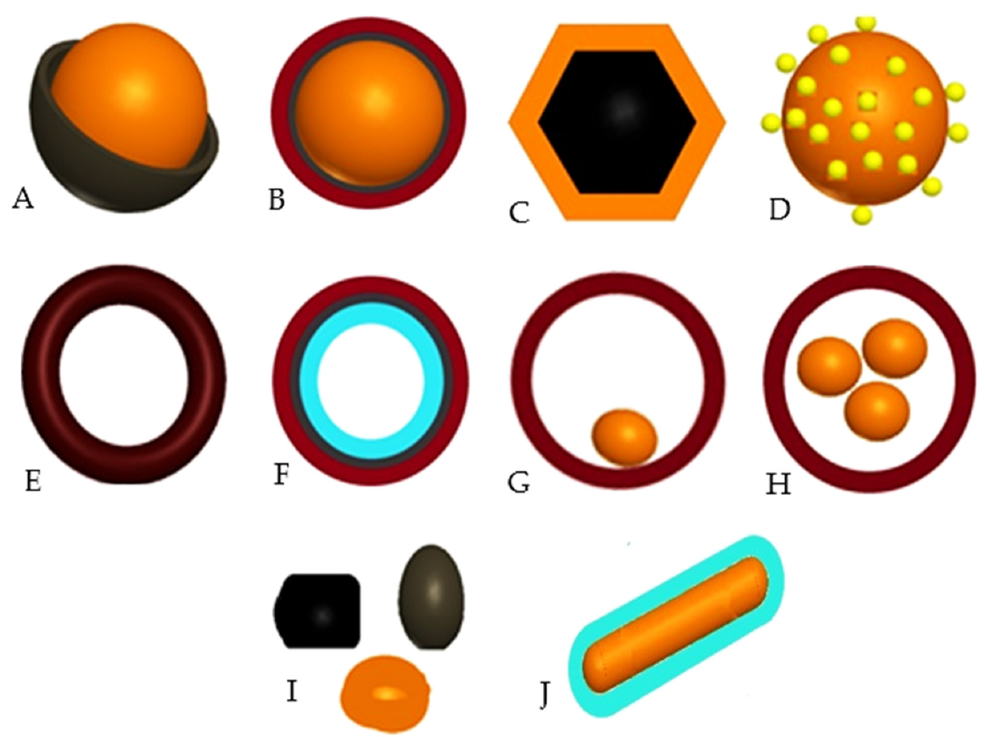
Figure 3. Schematic ( A – J ) pictures of different structure of core shell nanoparticles: ( A ) Core shell nanoparticles; ( B ) Core double-shell particles or core multi-shell nanoparticle; ( C ) Polyhedral core/shell nanoparticles; ( D ) Core porous-shell nanoparticles; ( E ) Hollow-core shell nanoparticles or single-shell core/shell nanoparticles; ( F ) Hollow-core double-shell nanoparticles; ( G ) Moveable-core shell nanoparticles; ( H ) Multi-core shell nanoparticles; ( I ) Irregular shape core shell nanoparticles; and, ( J ) Rod core shell nanoparticles.